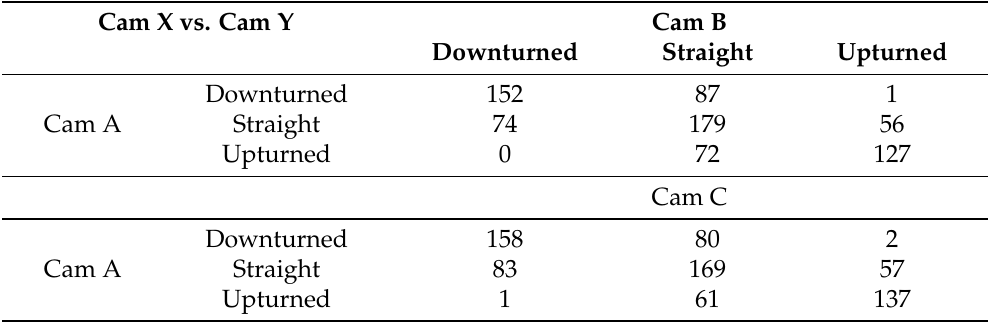
Table A4. Confusion matrices depict eye position attributes prediction in each individual camera versus another